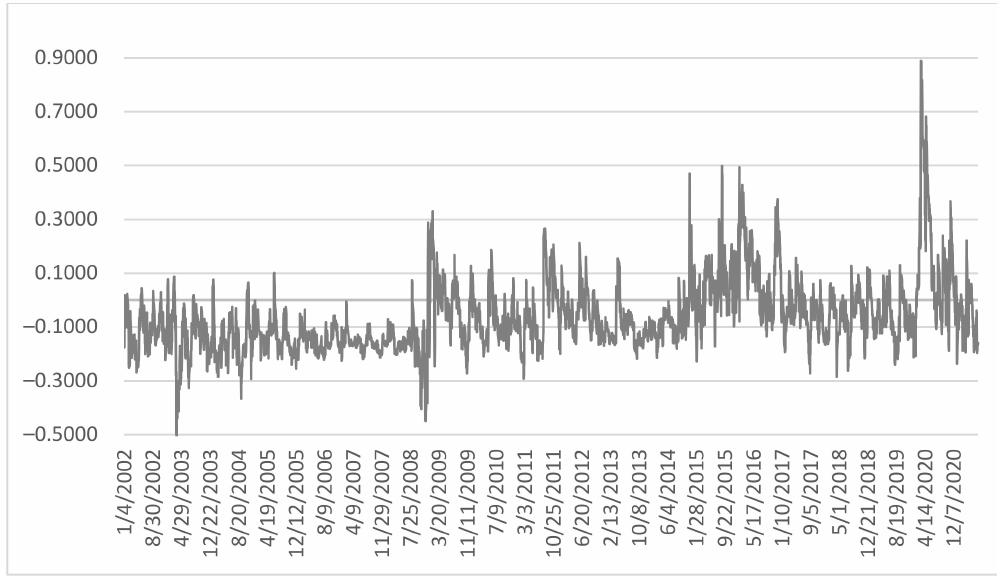
Figure 6. Estimation of the dynamic conditional correlation from model DCC(1,1) GARCH with the multivariate Student’s-t errors, between WTIF and